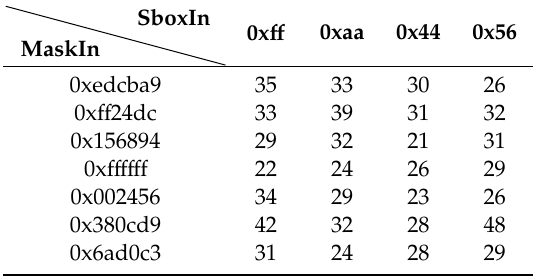
Table 3. Relation table between random delay mask S-box input value and the number of glitches.